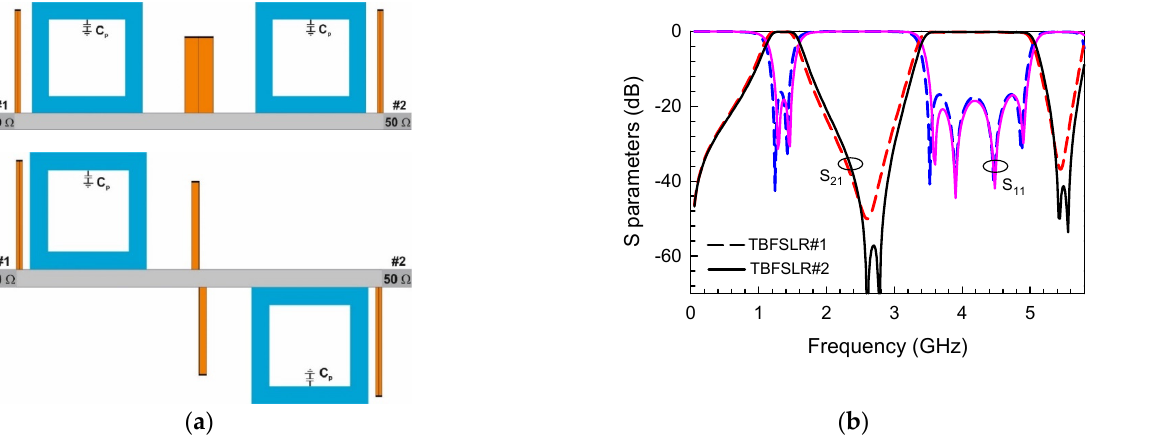
stubs placed between the input and output ports to increase modes in each passband. In